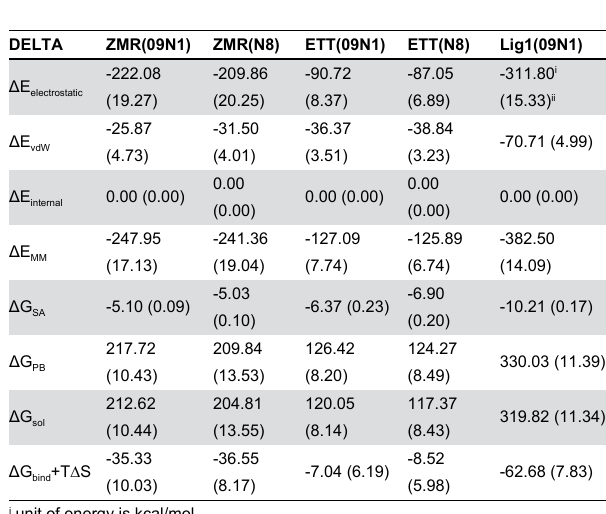
Table 5. Binding energies of ligands in different systems calculated by